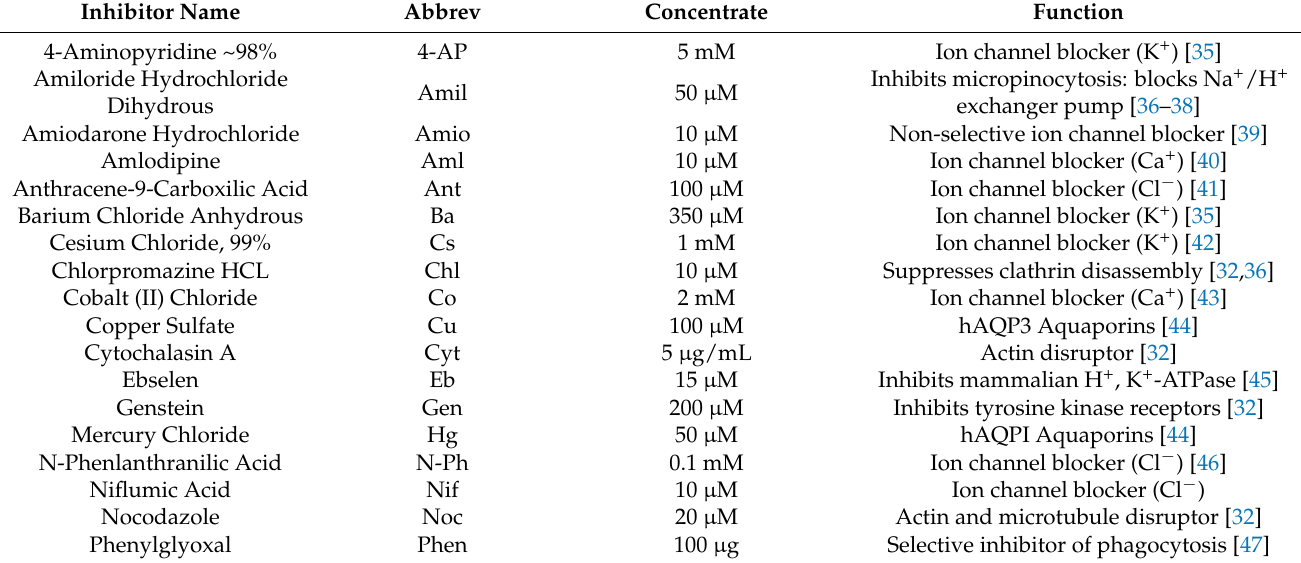
Figure 8. CND uptake with channel blockers HMEC-1 cells were treated with inhibitor 4-AP ( A ), Amil ( B ), Amio ( C ), Ant ( D ), Ba ( E ), Cs ( F ), Co ( G ), Cu ( H ),Eb ( I ), Hg ( J ), N-Ph ( K ), Nif ( L ) with concentrations described (Table 1), for 30 min. Cells were then washed two times with PBS and treated for 6 h with 0.1 mg/mL of CNDs. After CND treatment, cells were washed two times with PBS and removed. Cells’ fluorescence was checked using the Bio-Tek ® Synergy plate reader at 360/40 excitation and 460/40 emission. Channel blocking inhibitors displayed no significant change in fluorescent intensity. All data represent mean ± SEM. (n = 3–5, * p < 0.05 vs. Control). Table 1. Inhibitors used for uptake assay. List of channel blockers and endocytosis disruptors. Display of abbreviated name, concentrations used, and the function of the potential